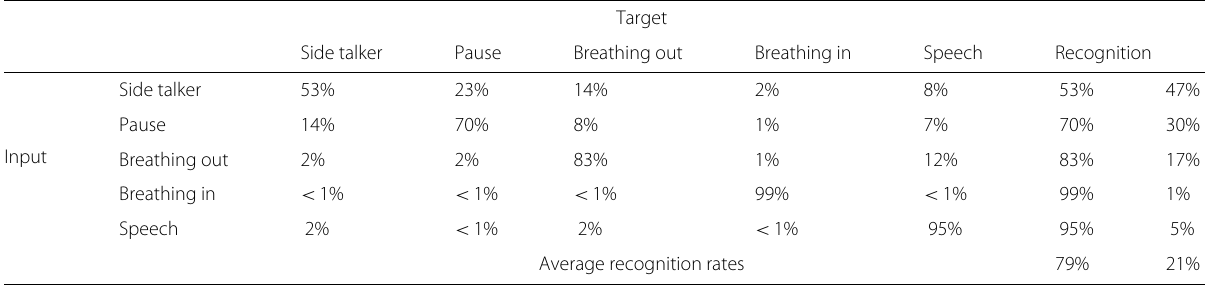
Table 1 Confusion matrix of the classification approach based on a neural